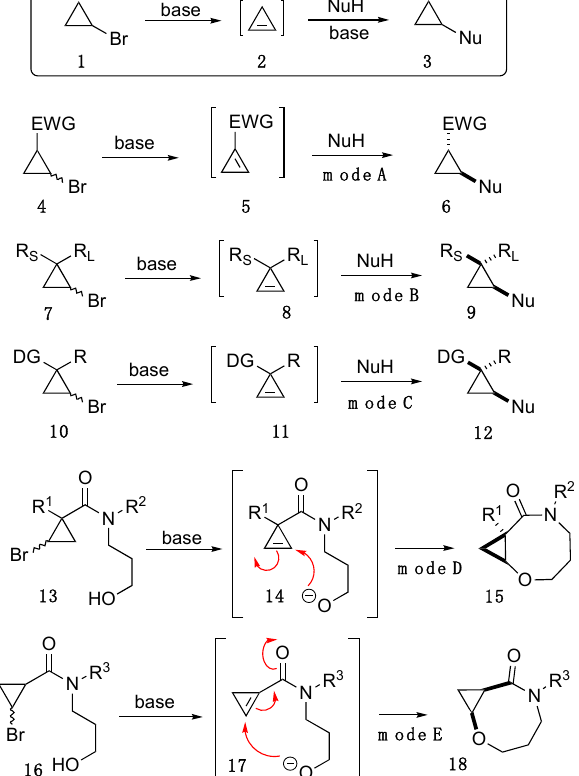
Scheme 1. Different modes of formal nucleophilic substitution of bromocyclopropanes (nota- used: EWG—electron-withdrawing group; DG—directing group; R S —small substituent; R L –large substituent).